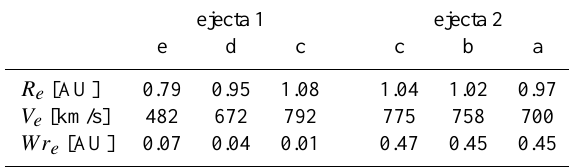
Table 5. Results in 2-D at the five radial cuts (a − e) at 57h after ejecta 1 initiation (Fig. 7): ejecta heliocentric distance ( R e ), ejecta front velocity ( V e ) and ejecta radial width ( Wr e